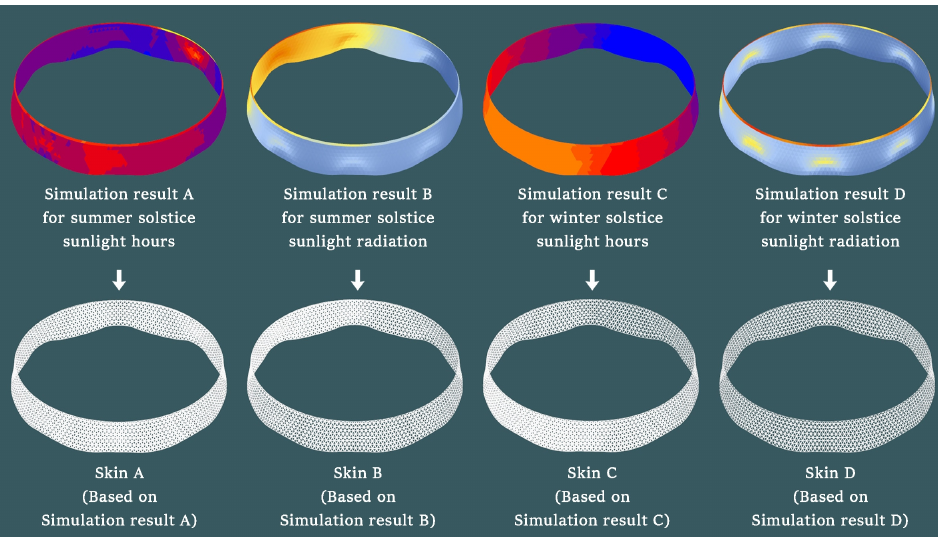
Figure 12. Four different skin types, A-D